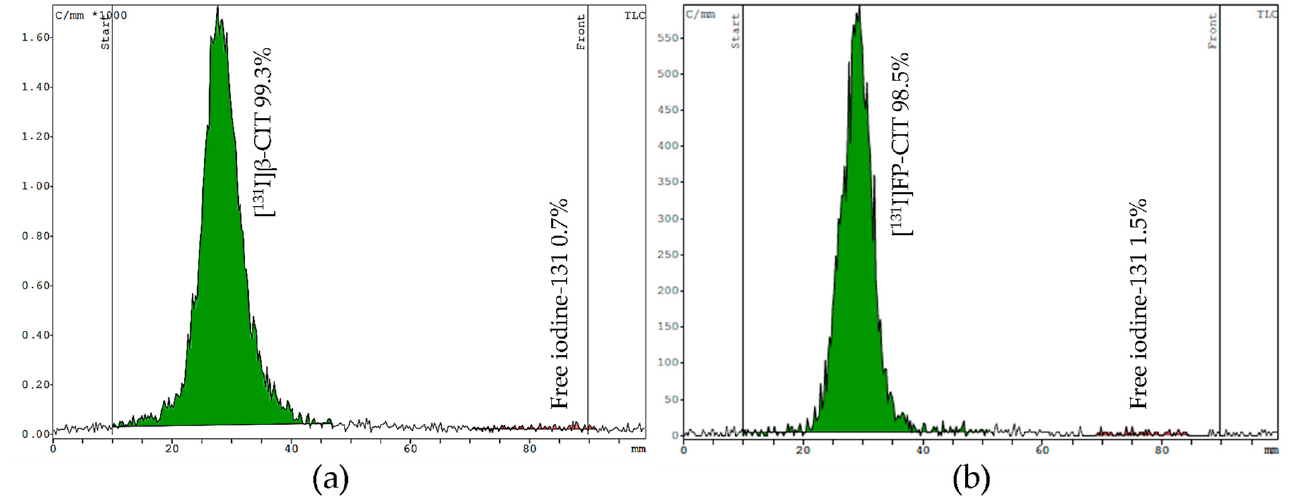
Figure 5. TLC radiochromatograms of [ 131 I] β -CIT ( a ) and [ 131 I]FP-CIT ( b ) developed in eluent II. The radiolabeled compound stays near the origin (Rf = 0.1–0.3) while free [ 131 I]NaI migrates to the front (Rf = 0.9–1.0).